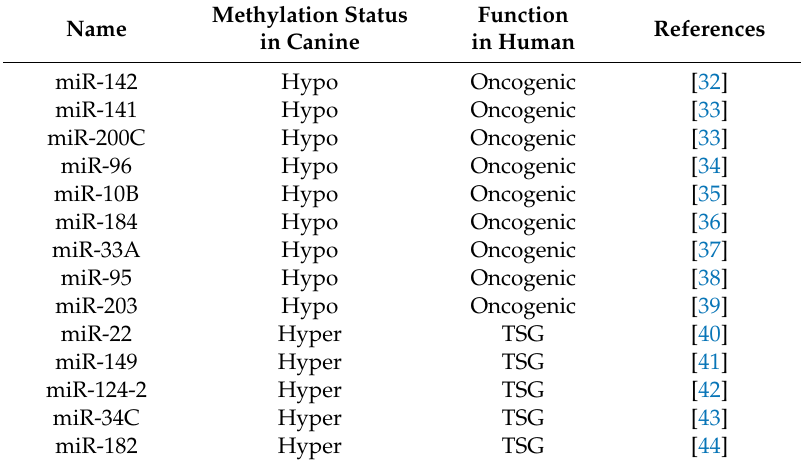
Table 2. Potential functions of di ff erent microRNAs (miRNAs) in cancer